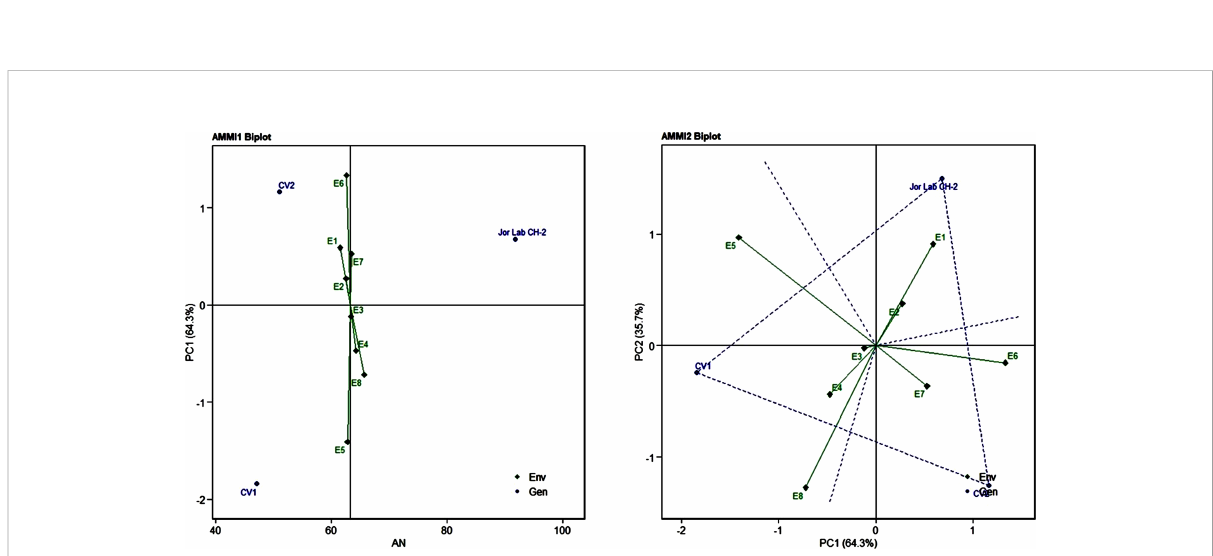
FIGURE 4 AMMI 1 and 2 model biplot for anethole content (%) of Jor Lab CH-2 compared with the check genotypes (CV1 and CV2) evaluated in eight environments.